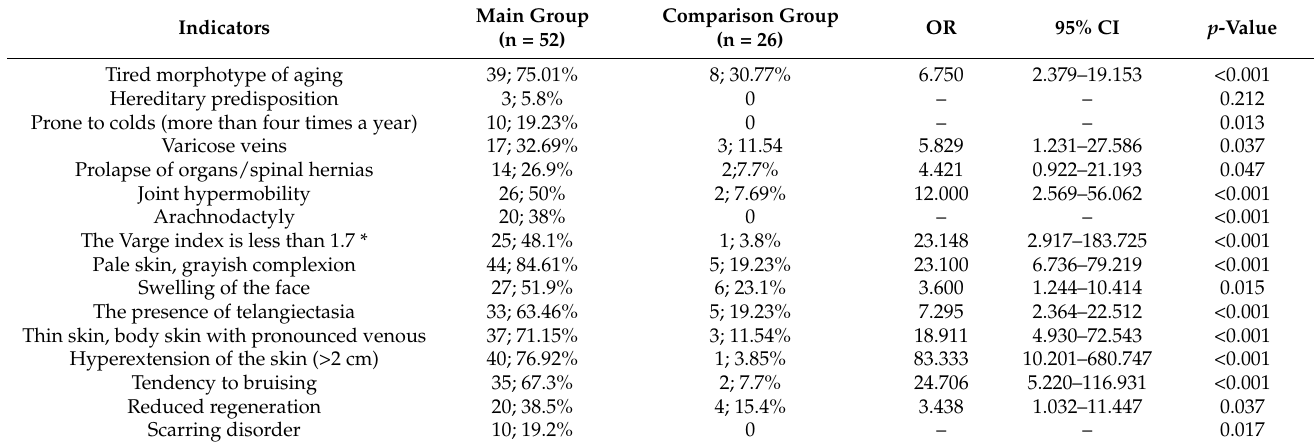
Table 4. The prevalence of indicators and odds ratio of the chances of premature aging, depending on the presence of indicators in the main group and the comparison